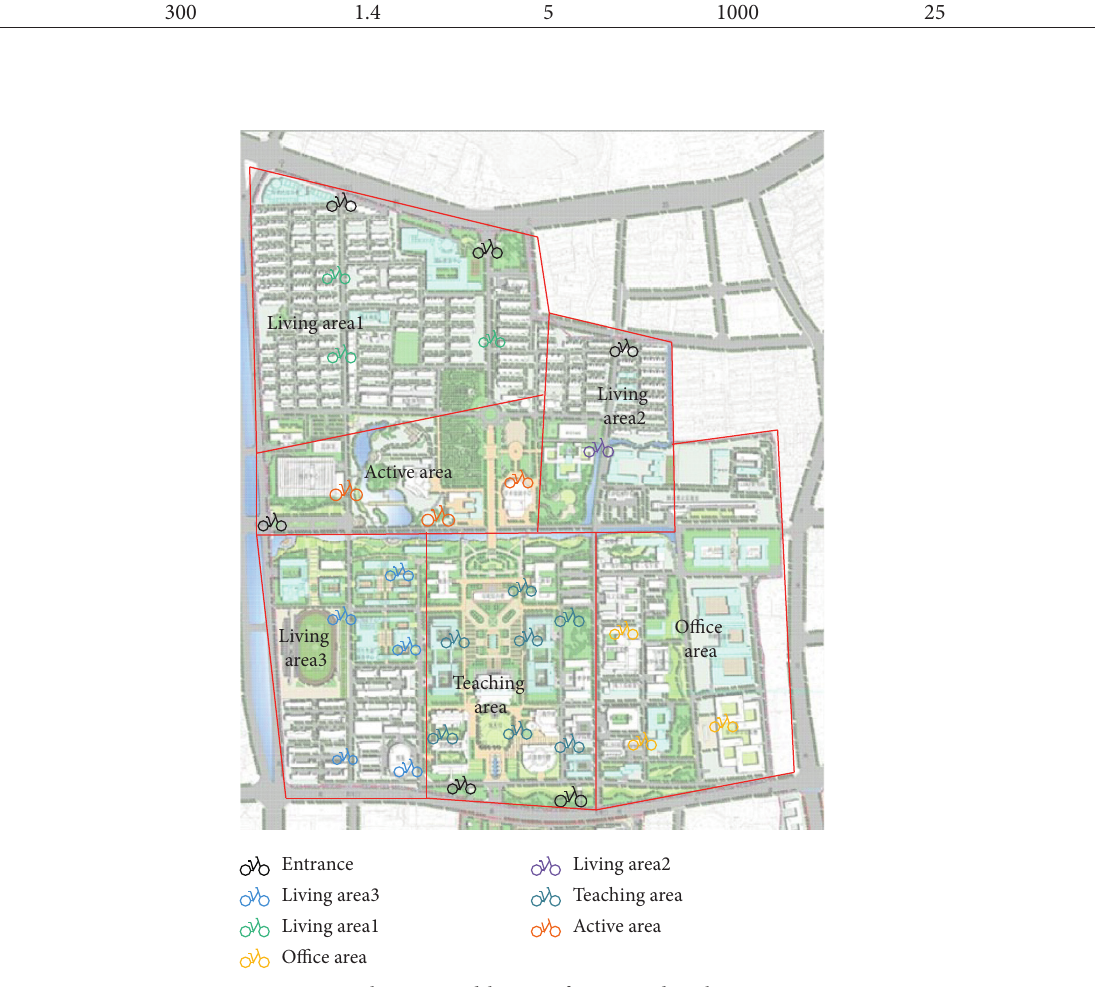
Figure 5: Planning and layout of optimized parking spots.